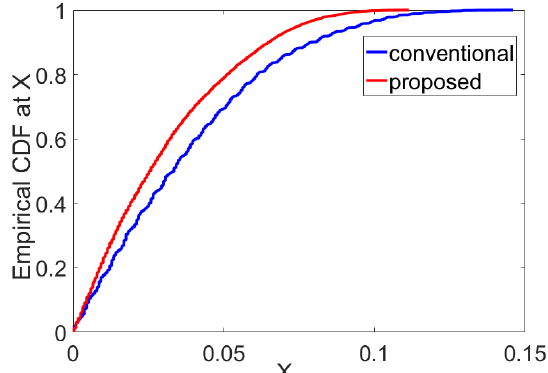
Figure 4. The Empirical CDF calculated for ranging error using half peak detection method and conventional peak detection